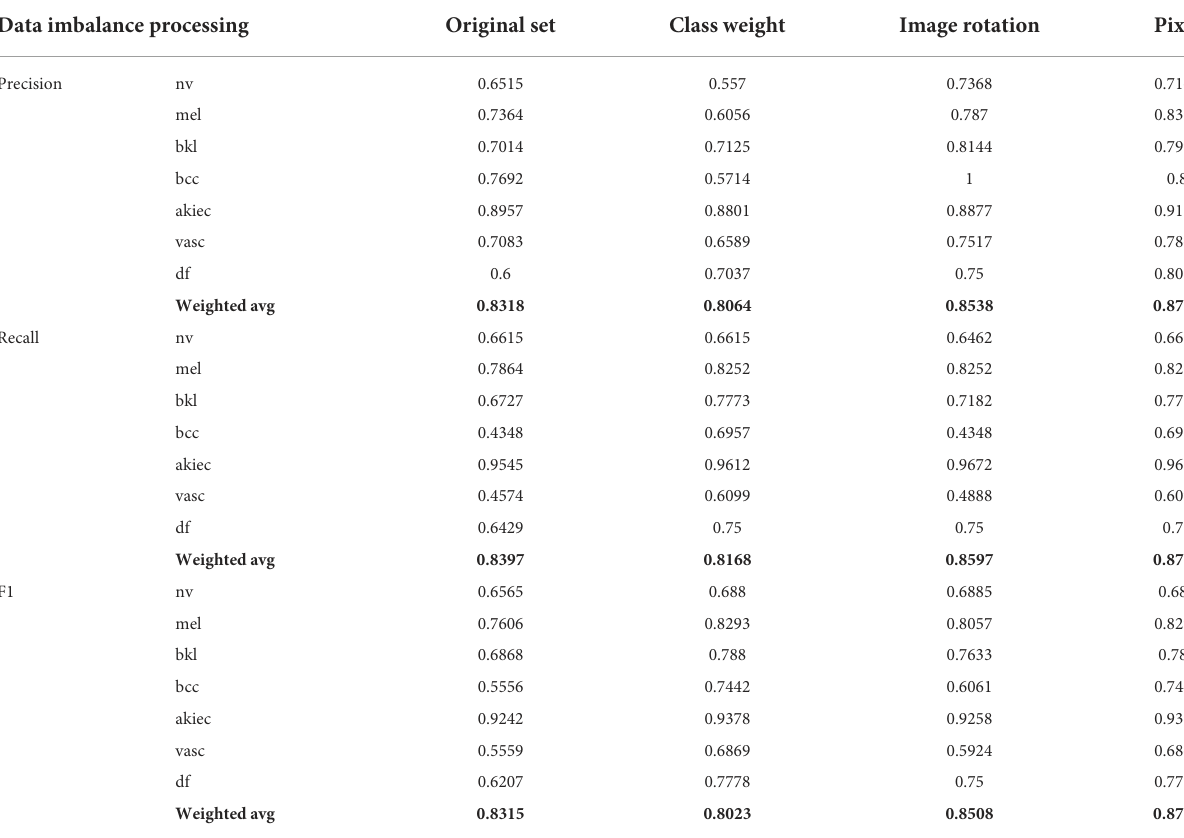
TABLE 3 The influence of the data imbalance treatment scheme on the